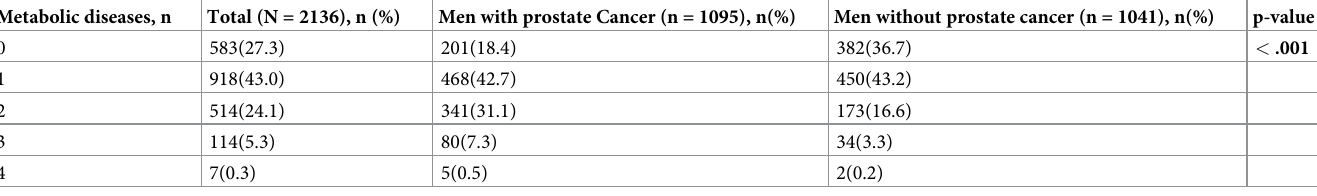
Table 4. Frequency of metabolic diseases � in men, overall and by case/control status. Metabolic diseases, n Total (N = 2136), n (%) Men with prostate Cancer (n = 1095), n(%) Men without prostate cancer (n = 1041),